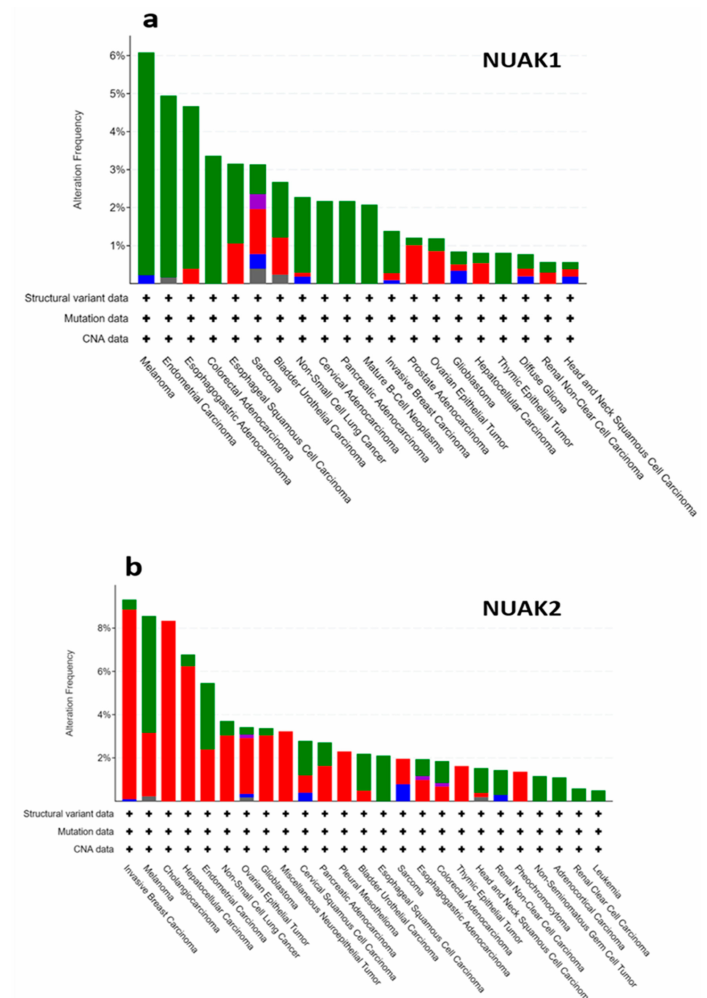
Figure 1. NUAK 1 and 2 gene alterations in the TCGA database. The graphs represent the percentage of alterations encountered in NUAK1 ( a ) and NUAK2 ( b ) from various patient cancer tissue samples, analyzed using the cBioportal database. NUAK1 is frequently mutated in many different cancer types. Higher NUAK1 mutation frequency has been found in colorectal cancer, endometrial cancer, and melanoma. Whereas NUAK2 is found broadly amplified in different cancer types with higher frequency in breast cancer and melanoma. Similar to NUAK1, NUAK2 has been also found altered in reproductive cancers as ovarian and prostate cancer, glioblastoma, and colorectal